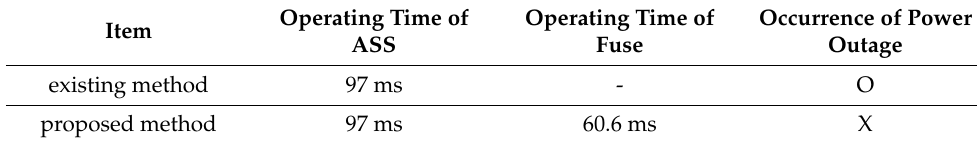
Table 2. Comparison of simulation